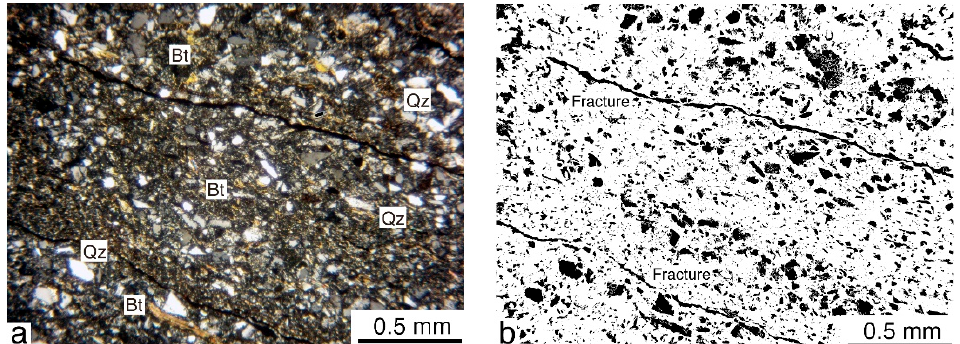
Figure 9. An example of the grain outline data acquired with GIMP. Sample B6_8.2 m_Area V_DB. ( a ) Microphotograph of the deformation bands area (cross-polarized light). ( b ) Acquisition of grain boundaries with